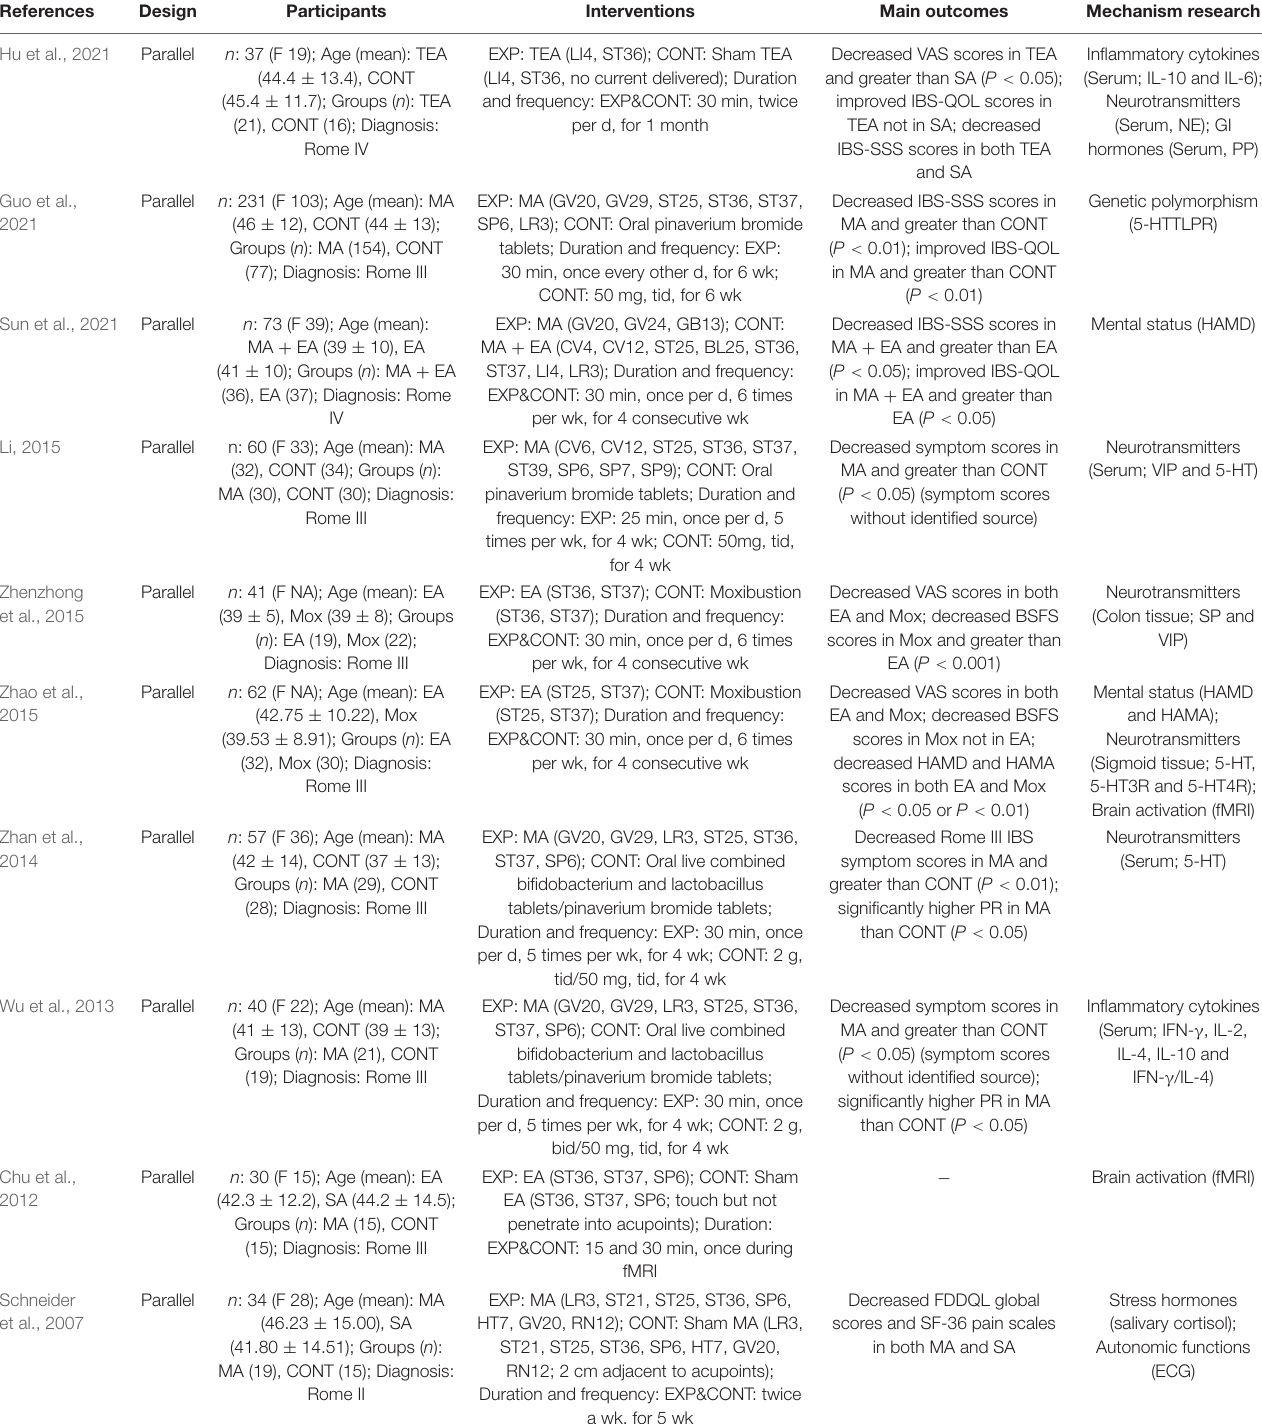
TABLE 1 | Characteristics of included studies of acupuncture vs. sham acupuncture, medication, and moxibustion in treating Diarrhea-Predominant Irritable Bowel